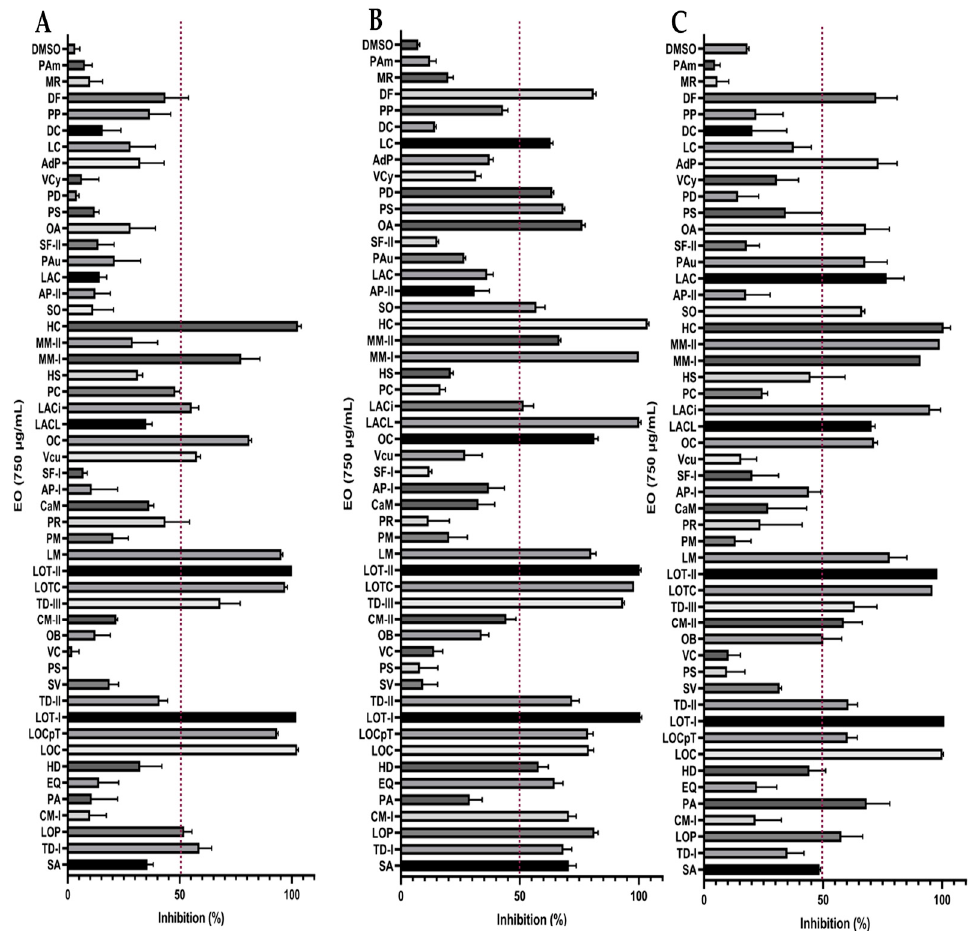
Figure 1. Screening of antifungal activity of 50 EOs (750 µg/mL) against ( A ). C. albicans ATCC 10231, ( B ). C. parapsilosis ATCC 22019, and ( C ). C. auris CDC B11903 after 48 h of treatment. Table 2. MIC 50 and MFC values for the most active EOs studied against C. albicans ATCC 10231, C. parapsilosis ATCC 22019, and C. auris CDC B11903 after 48 h of culture. C. albicans ATCC 10231 C. parapsilosis ATCC 22019 C. auris CDC EO